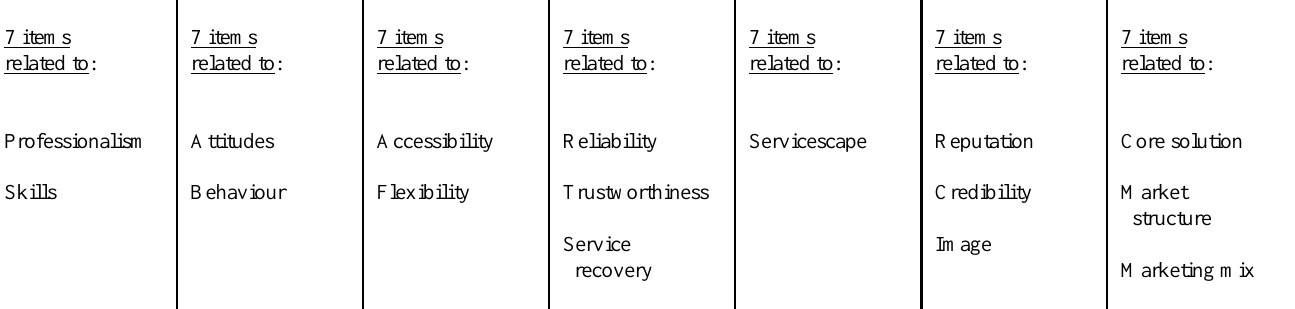
Table 1: Theoretical structure of the Q sample 7